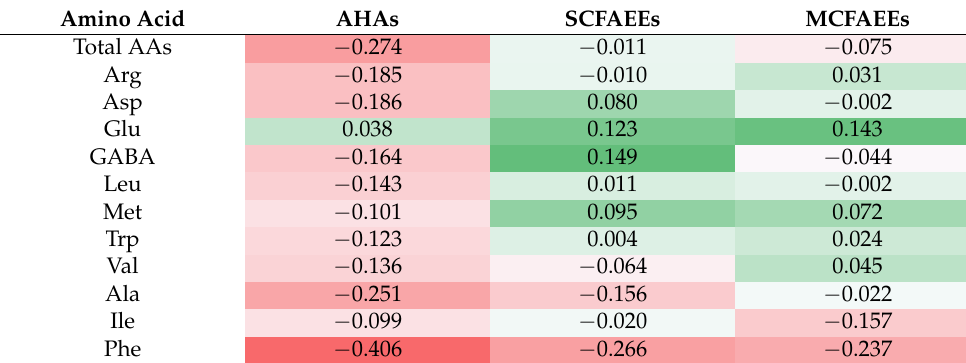
Table 2. Difference in Pearson’s correlation coefficients (r) during Cabernet Sauvignon and spine grape fermentation. Data were calculated by r cabernet sauvignon − r spine grape , where r cabernet sauvignon indicates the correlation coefficient of Cabernet Sauvignon fermentation and r spine grape indicates the correlation coefficient of spine grape fermentation. Red cell means the correlation coefficient during spine grape fermentation was less than that during Cabernet Sauvignon fermentation. The darker the red, the weaker the correlation between the amino acids and fruity ester during spine grape fermentation. AHA, acetate of higher alcohol; SCFAEE, short-chain fatty acid ethyl ester; MCFAEE, medium-chain fatty acid ethyl ester. Amino Acid AHAs SCFAEEs